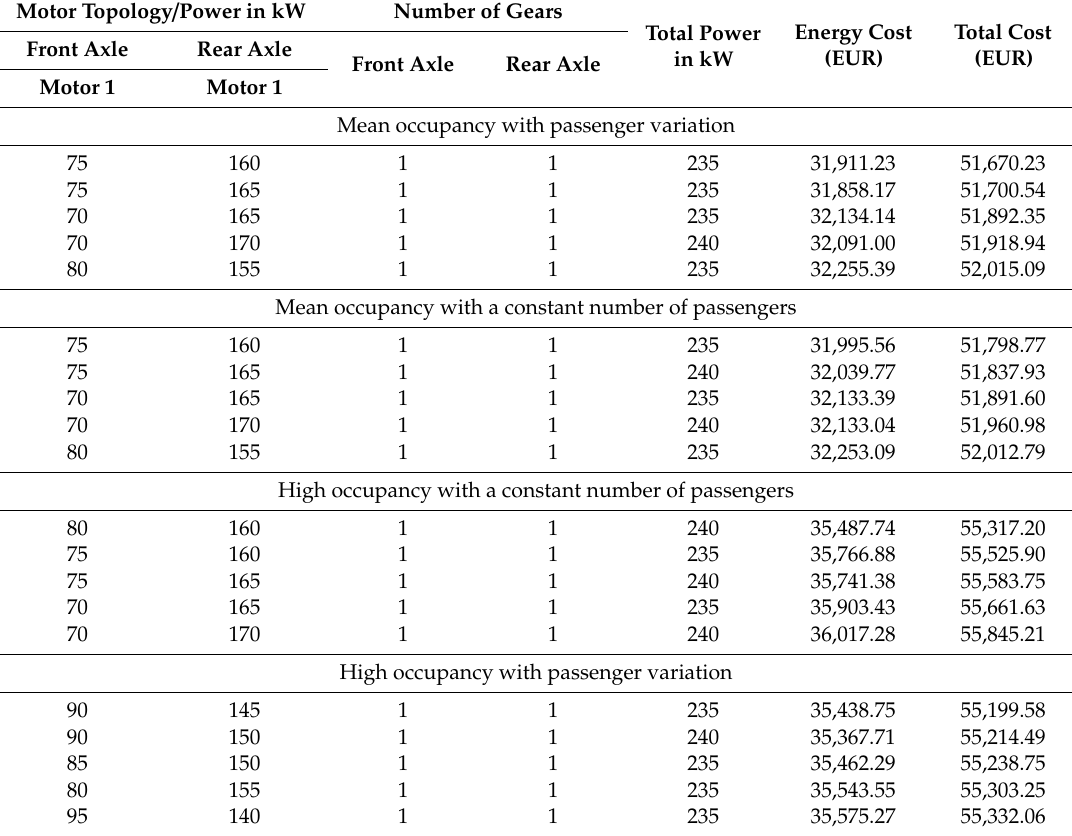
Table 4. Five best cost-competitive configurations for di ff erent passenger